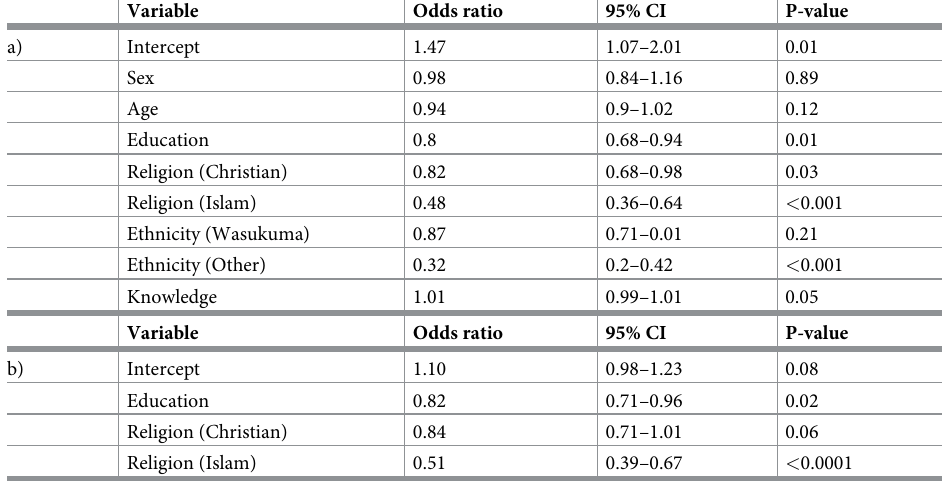
Table 6. Predictors for the use of practices by agro-pastoralists risking brucellosis infection for a) null model and b) final